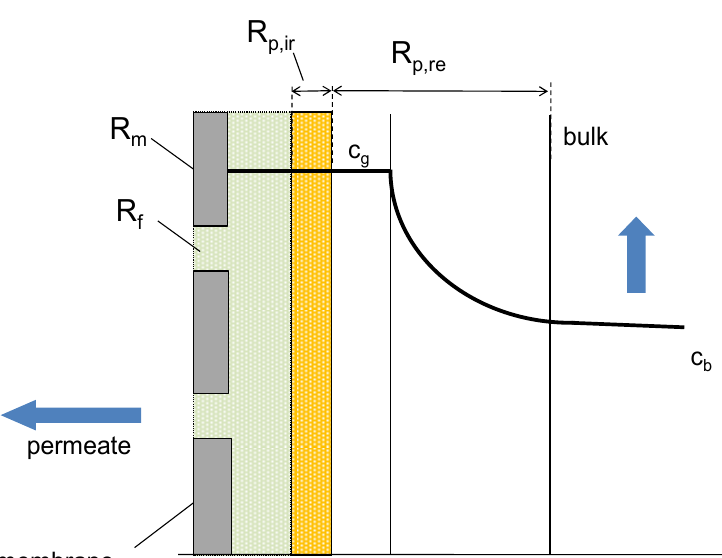
Figure 5. Schematic representation of the resistance ‐ in ‐ series model (R m , membrane resistance; R f , fouling resistance; R p,re , resistance of the reversible polarized layer; R p,ir , resistance of the semi ‐ reversible polarized layer; c g , gel concentration; c b , bulk concentration).